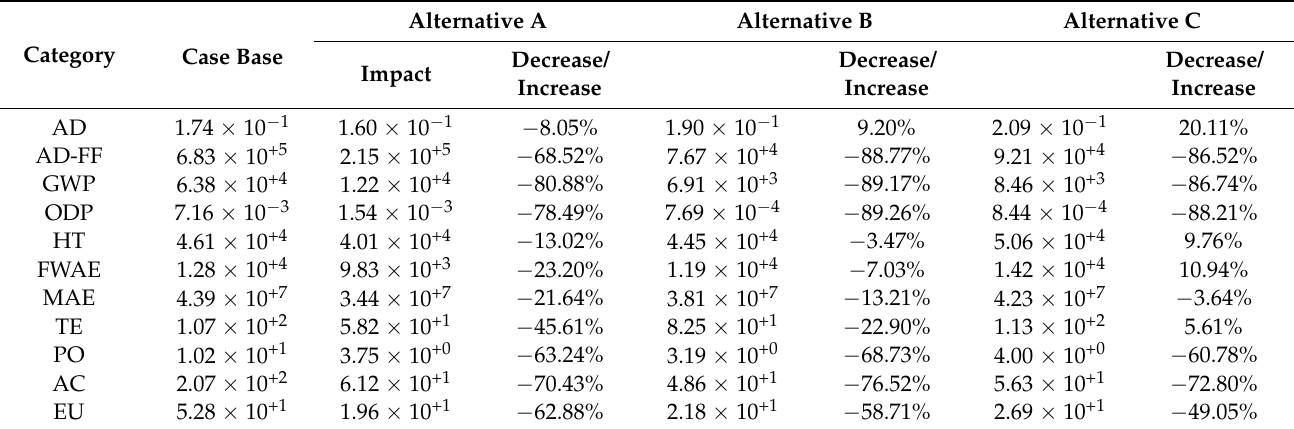
Table 7. Comparison of the environmental impact of the three alternatives with the base